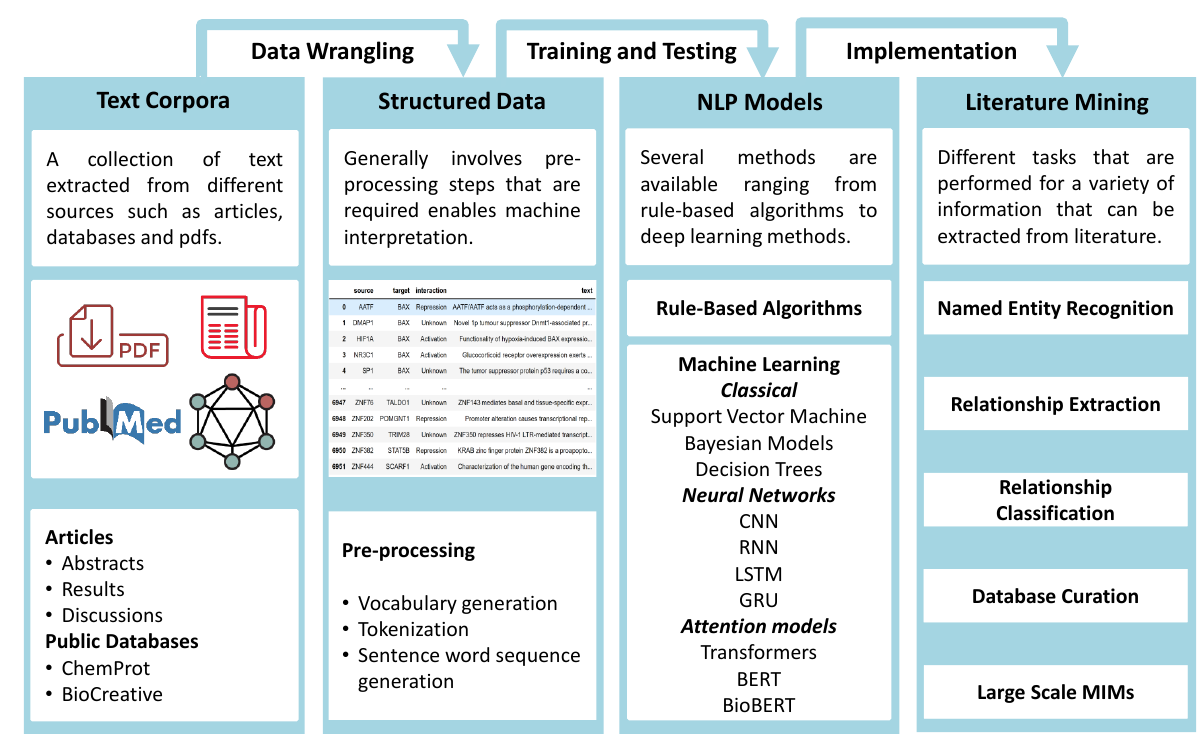
Figure 1. Workflow for Biological Literature Mining (BLM). Starting with a collection of texts from different sources to processing them into structured data for modeling. Choosing from a plethora of NLP models such as BioBERT to perform BLM tasks such as NER and RE to extract information from the